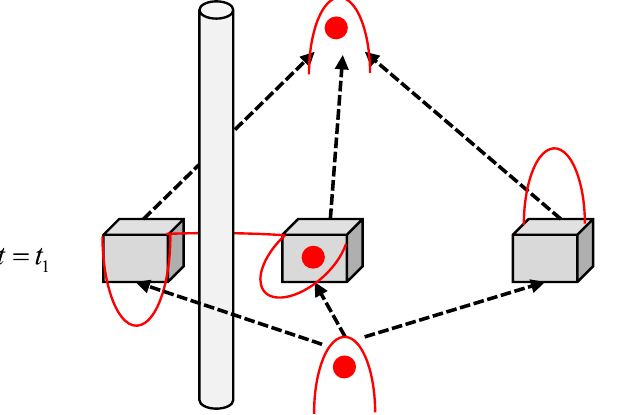
Figure 4. Inserting a magnetic flux source (a solenoid) between the first and second boxes a brief period before t =